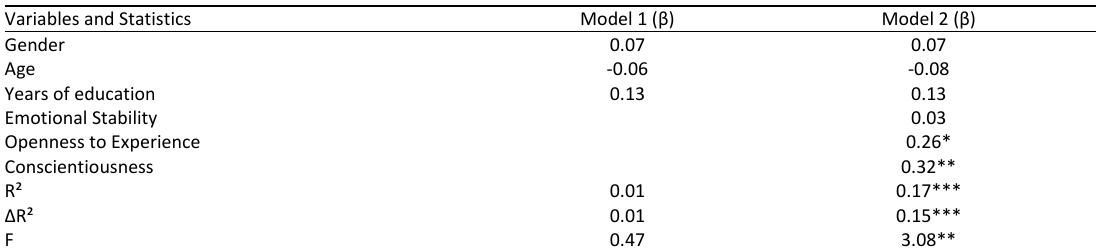
Table 4: Hierarchical Regression